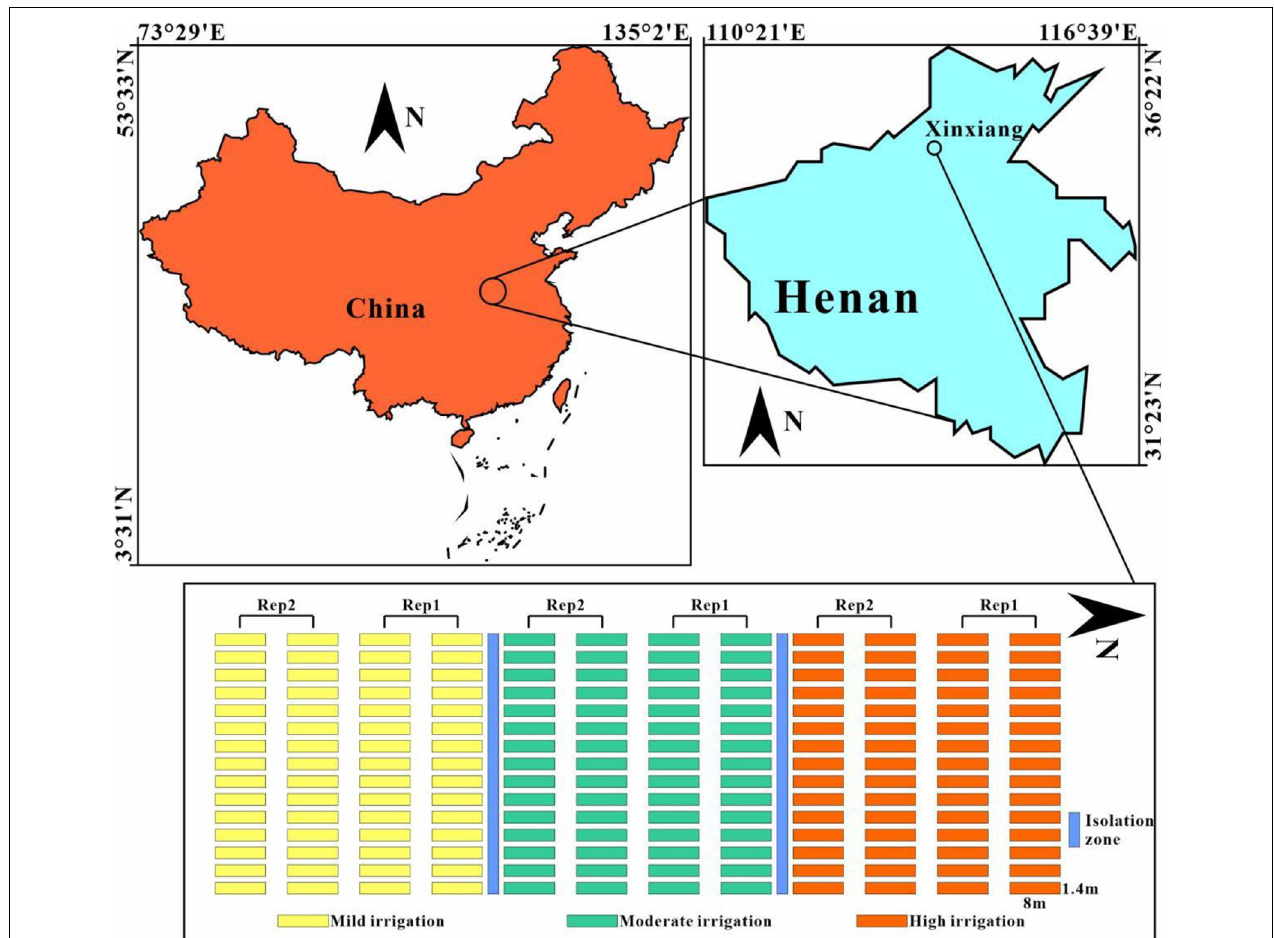
FIGURE 1 | Experimental location, design, and management.